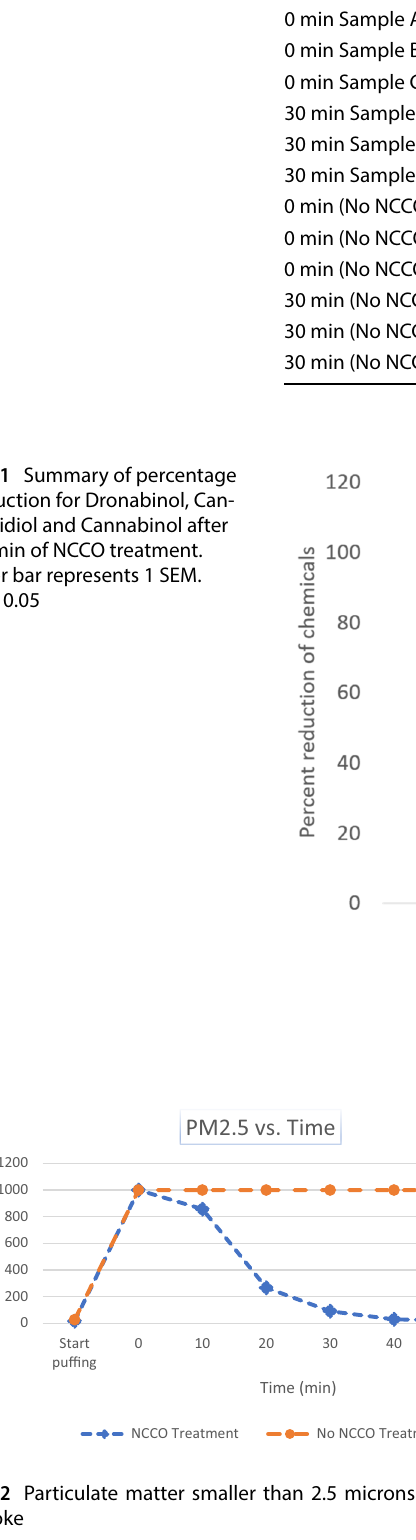
Table 2 Air concentration of marijuana chemicals and percentage reduction after 30 min